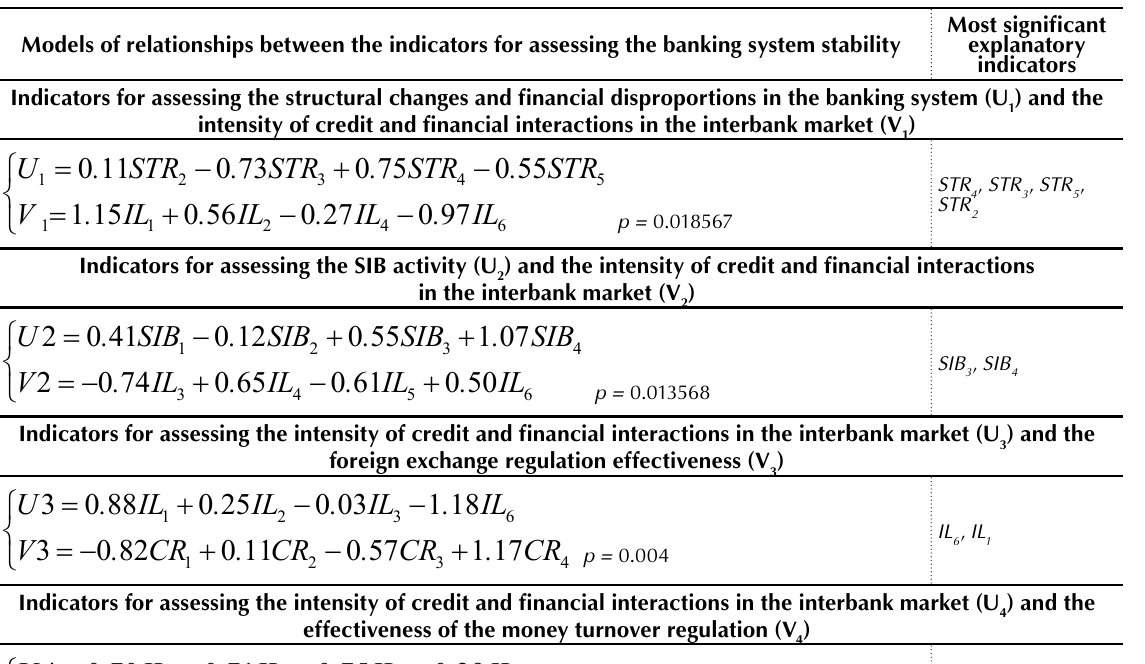
) and assessing the SIB activity (V 6